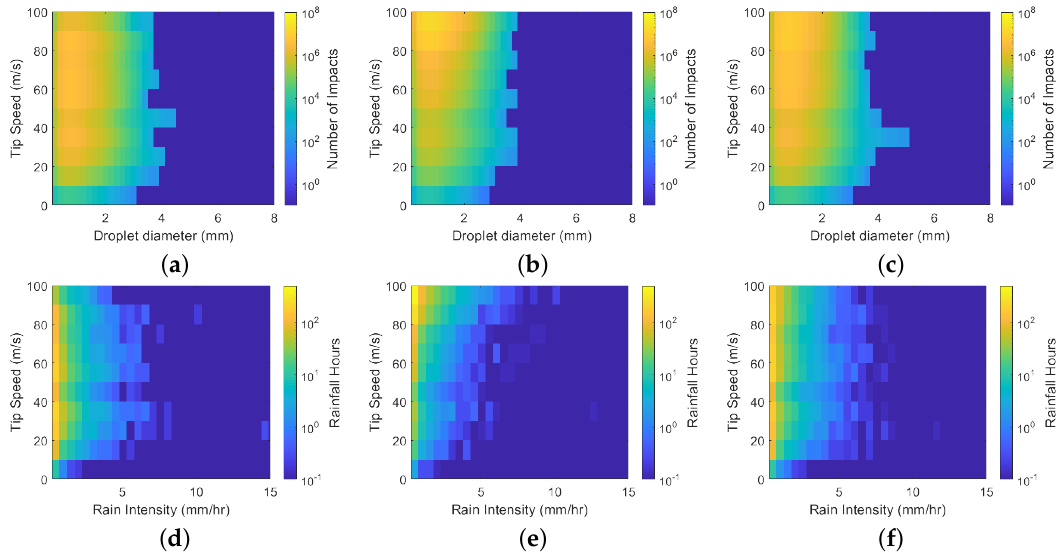
Figure 10. Annual impact distributions for the sites: A ( a ), MA ( b ) and N ( c ) for each given speed bin. Total annual number of rainfall hours at a given rain intensity, for a given speed bin for A ( d ), MA ( e ) and N ( f ). Across all stations, the mean and standard deviation of droplet size increased with velocity (Figure 11). In the rated bin, all stations displayed a mean droplet size in the range of 0.95 mm–1 mm, with a large standard deviation in the range of 0.8 mm–0.9 mm.